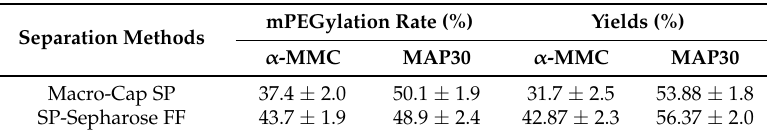
Table 1. Yields of 10 kDa mPEG- α -MMC and 10 kDa